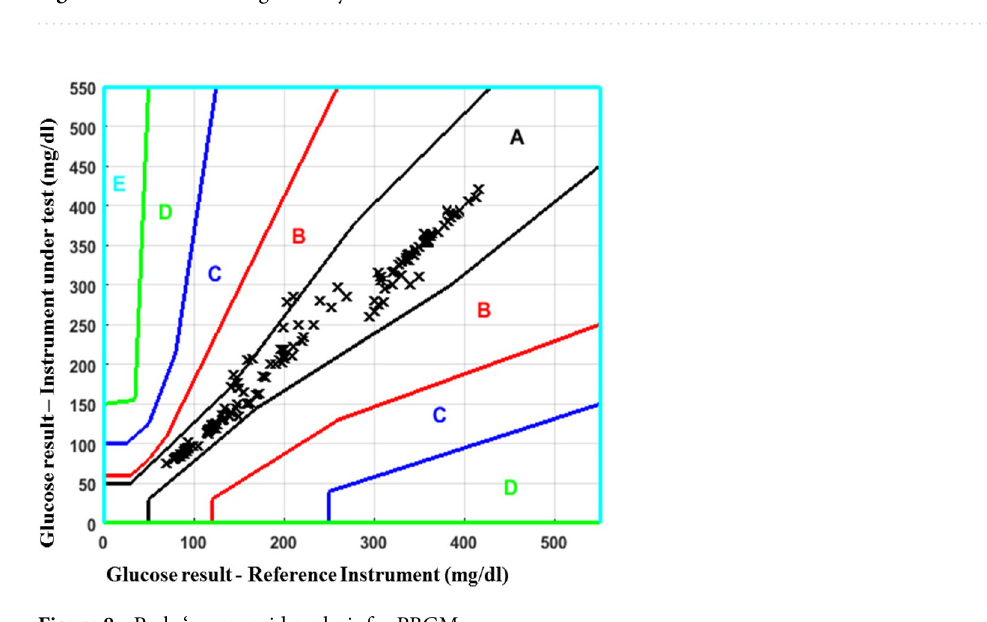
Figure 7. Clarke‘s error grid analysis for PBGM.